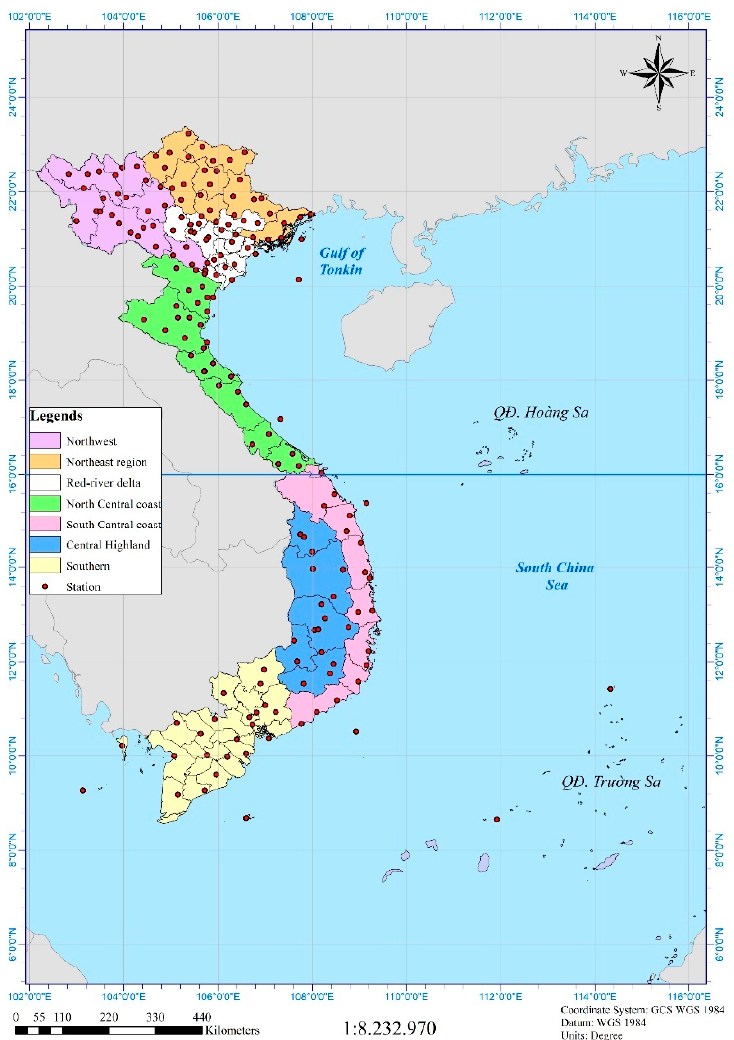
Figure 1. The map of the study region, land areas of Vietnam, the Vietnamese synoptic observation stations (brown dots) over different sub-climate regions, and the division of Vietnam into North and South Vietnam (horizontal line at 16° N).